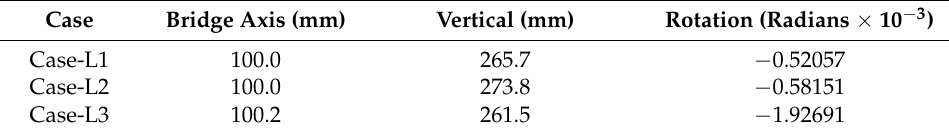
Table 7. Displacements at the end of the cantilever girders caused by the heating process.